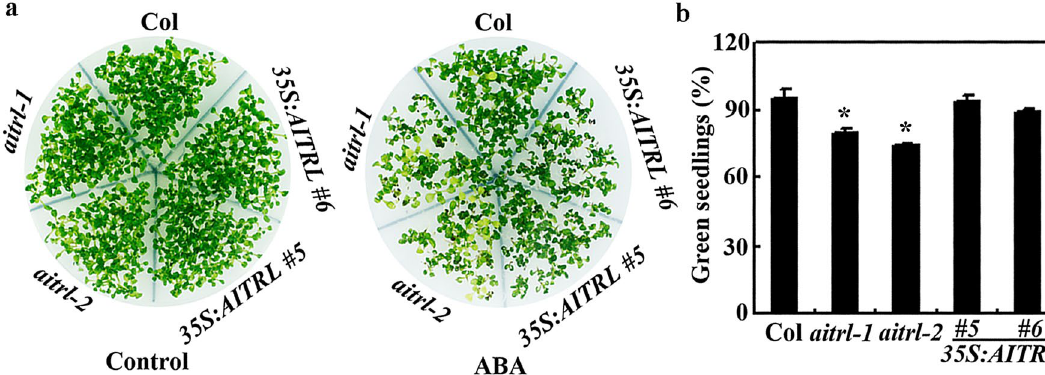
Figure 5. Effects of ABA on seedling greening of the Col wild type, the 35S:AITRL transgenic plants and the aitrl mutants. ( a ) Seedling greening of the Col wild type, the 35S:AITRL transgenic plants and the aitrl mutants in response to ABA treatment. Seeds were sterilized and sown on plates with solidified 0.5 × MS salts in the presence or absence 0.5 µM ABA. The plates were kept at 4 °C in darkness for 3 days before transferred to a growth room. Pictures were taken 12 days after the transfer. ( b ) Percentage of green seedlings of the Col wild type, the 35S:AITRL transgenic plants and the aitrl mutants in response to ABA treatment. Seedlings with green cotyledons were counted 12 days after the transfer, and the percentage of green seedlings was calculated. Data represent means ± SD of three replicates. *Significantly different from the wild type (p <